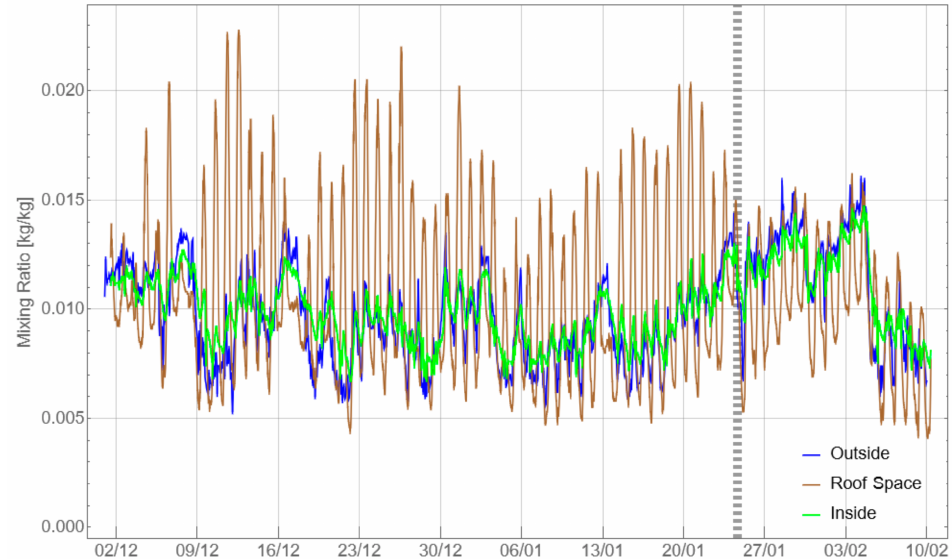
Figure 5. Water/air mixing ratio data as in Figure 4. The vertical dashed line represents the installation of the daytime only roof ventilator, showing the removal of the excess moisture from the roof